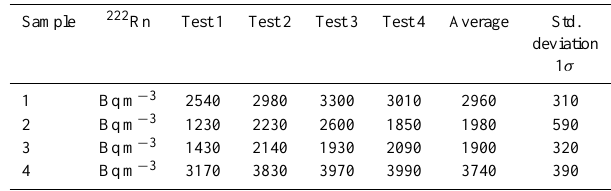
Table 1. Activity of water equilibrated with streambed sediments in four